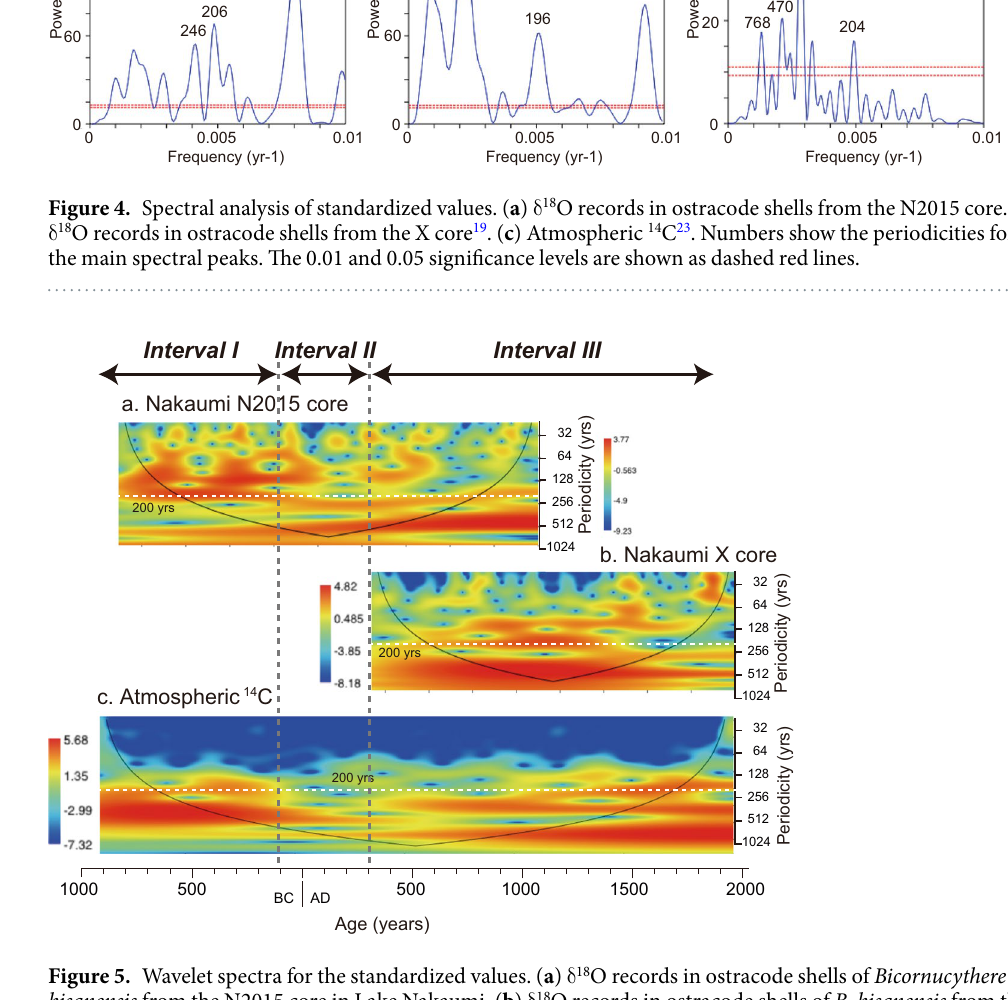
Figure 5. Wavelet spectra for the standardized values. ( a ) δ 18 O records in ostracode shells of Bicornucythere bisanensis from the N2015 core in Lake Nakaumi. ( b ) δ 18 O records in ostracode shells of B . bisanensis from the X core in Lake Nakaumi 19 . ( c ) Atmospheric 14 C 23 . The power is represented by colours ranging from deep blue (weak) to red (strong). A ~200 yr cycle is shown by a white dotted line. The thin black lines indicate the 95% significance